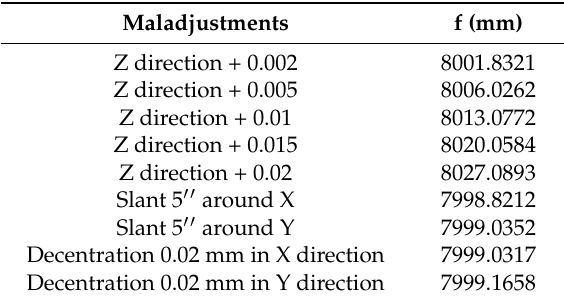
Table 5. Simulation calculation results using the proposed method.